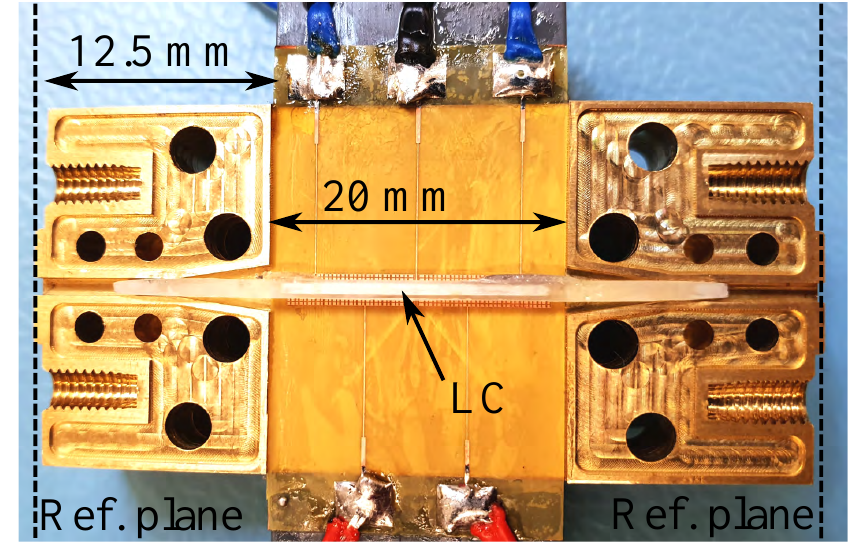
Figure 25. Photograph of the partially assembled NRD phase